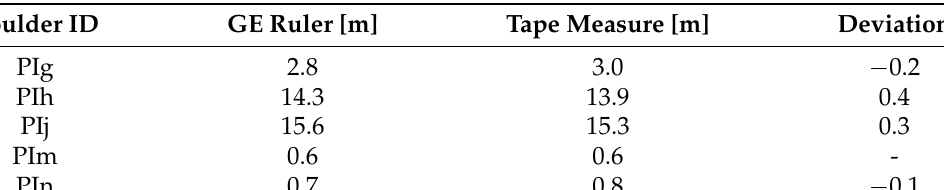
Table A17. Difference between the measurements taken with the GE’s ruler tool and the tape measure at the central area of Punta Pizzo headland.